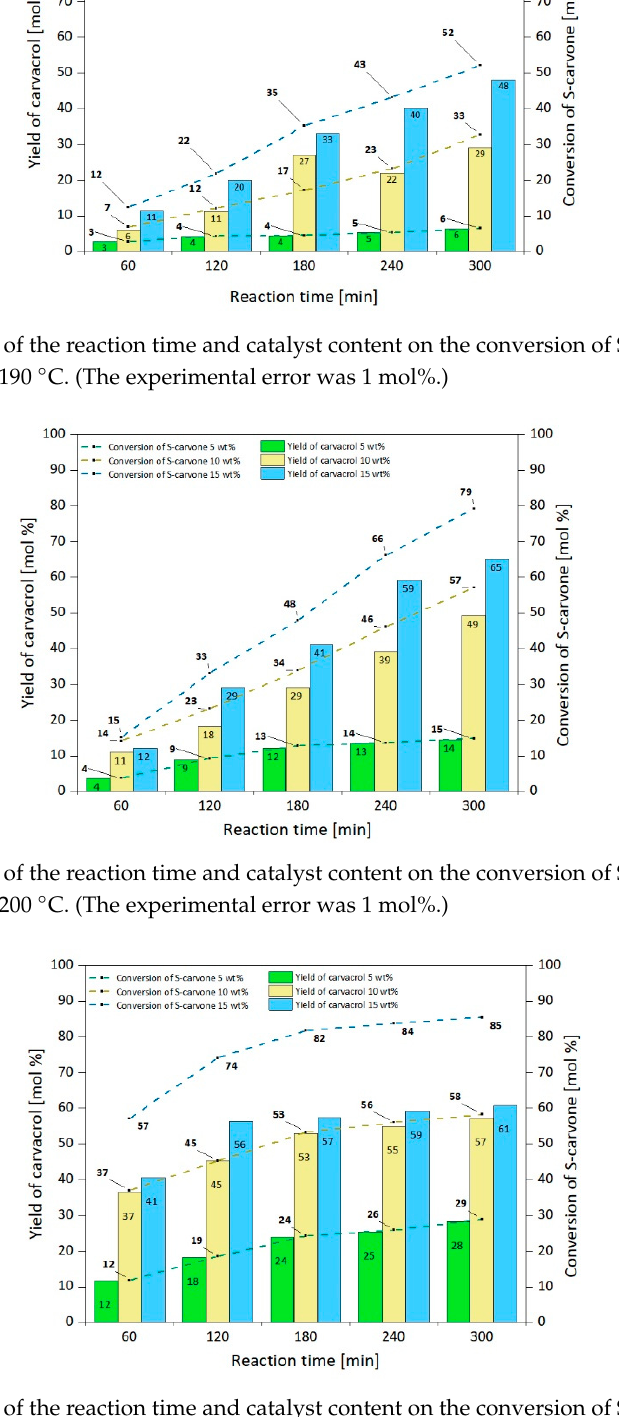
Figure 15. Influence of the reaction time and catalyst content on the conversion of S-carvone and the yield of carvacrol at 210 °C. (The experimental error was 1 mol%.)